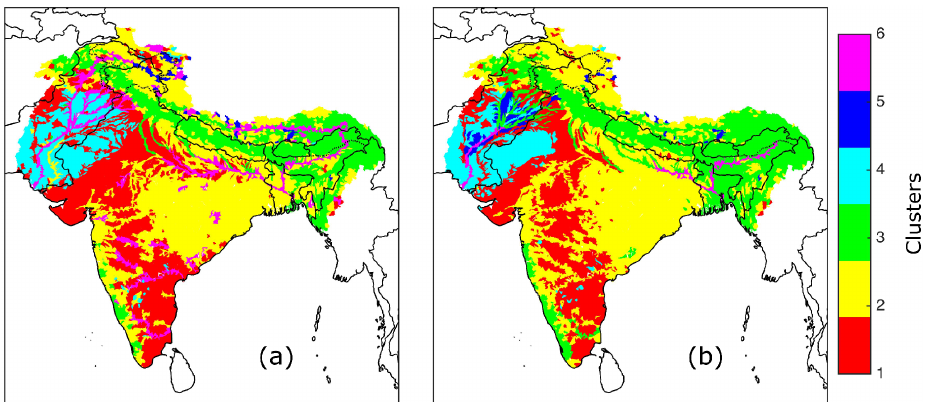
Figure 13. Subbasin clusters based on flow signatures at different stages of the model set-up: (a) prior, and (b)